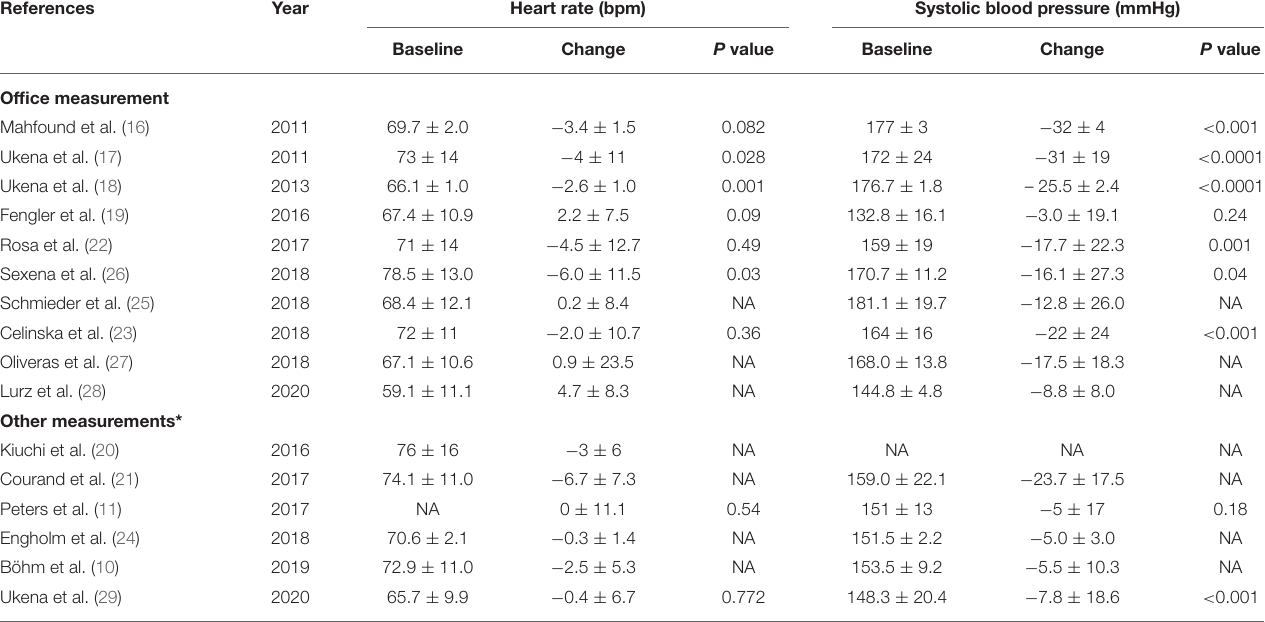
TABLE 3 | Extracted data of the included